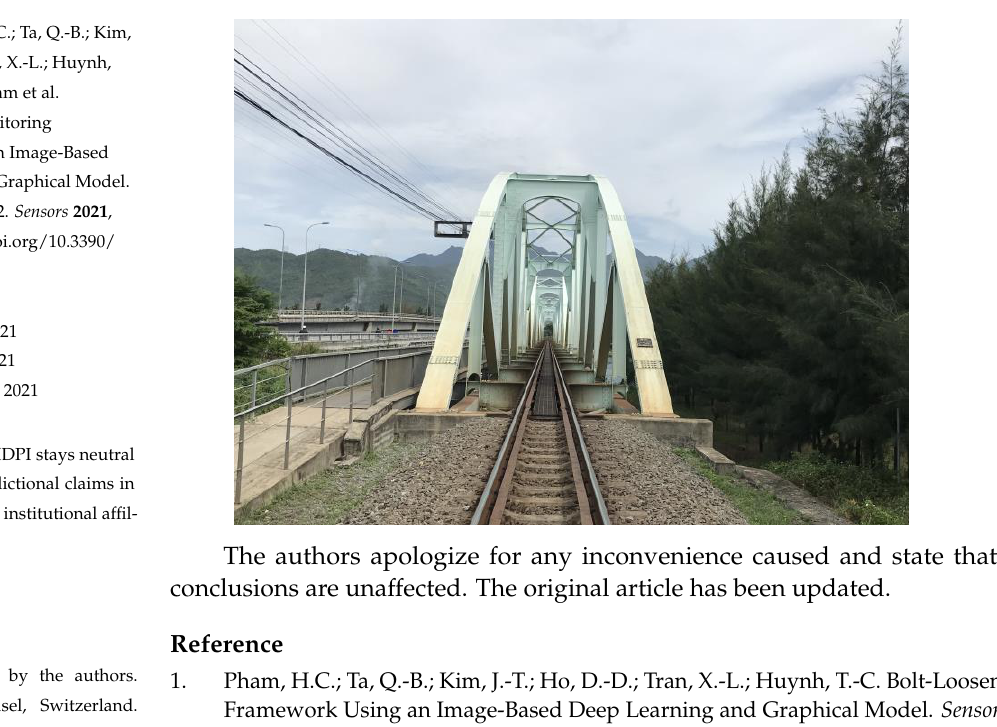
Figure 13b should be replaced by the following picture: